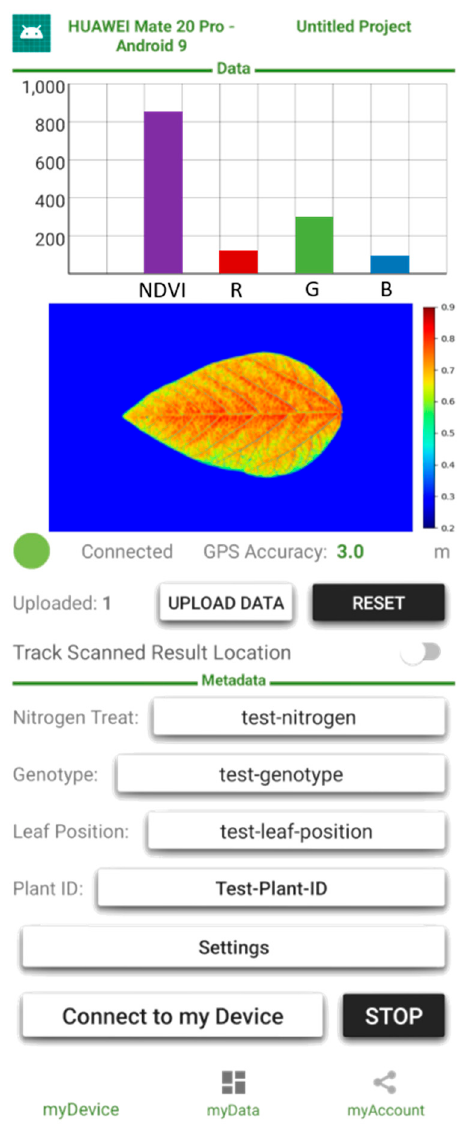
Figure 4. The LeafSpec App on Android.